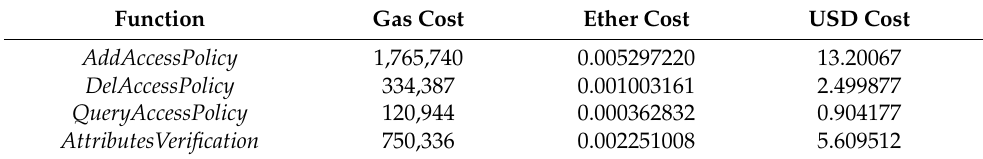
Figure 6. The gas cost of calling different functions in ACC under different attribute values. Table 3. Gas cost in ACC. ( gasPrice = 3 Gwei, 1 Ether = 2492.5 USD, Number of Attributes is